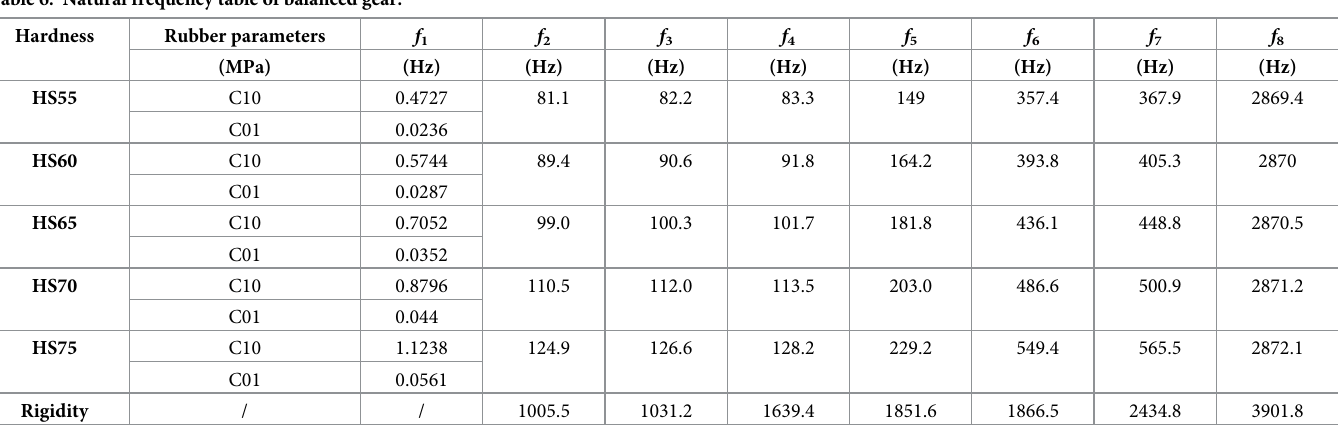
Table 6. Natural frequency table of balanced gear.